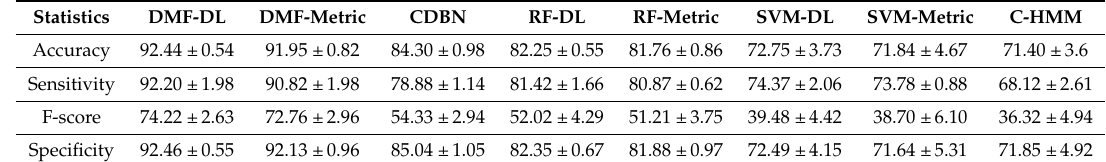
Figure 7. Confusion matrices showing predictions as rows and ground truth labels as columns for eight different methods. Numbers inside the confusion matrices represent percentages over the total number of samples predicted as a specific tag. Table 1. Performance values for the methods in Figure